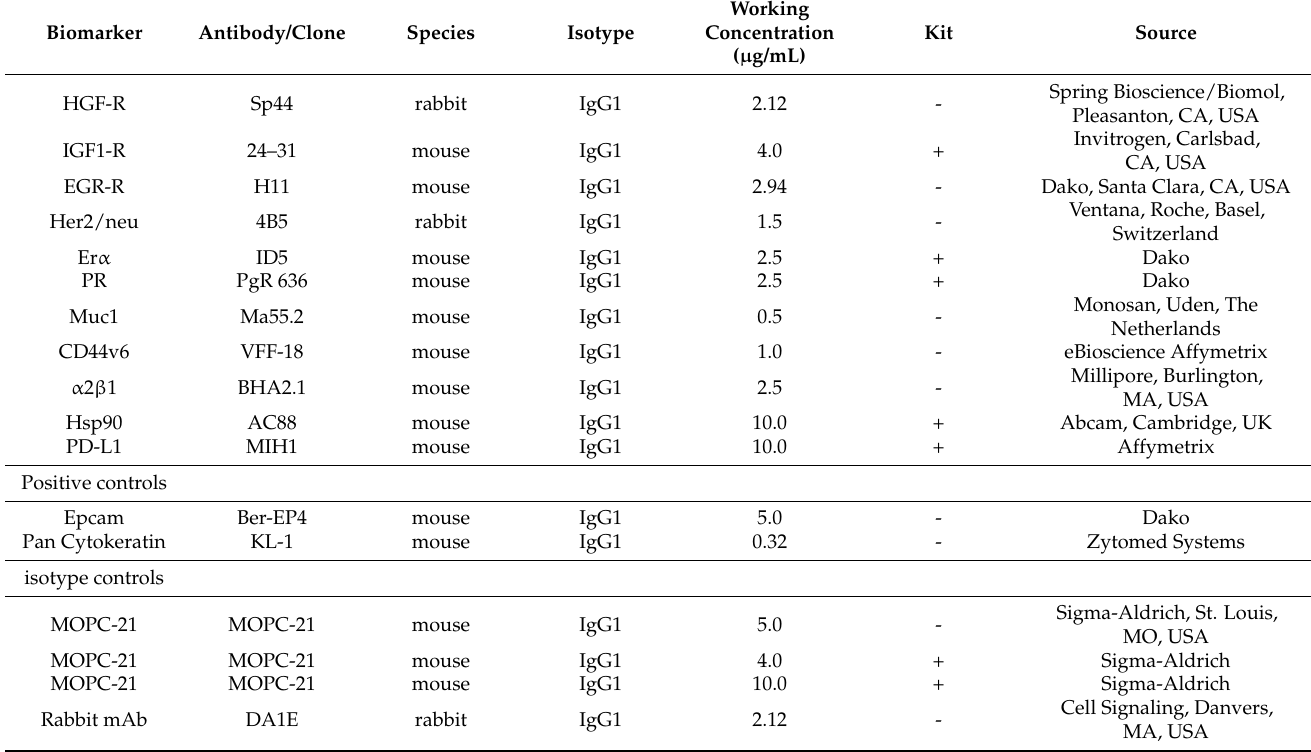
Table 1. Antibody Panel for Immunophenotyping of Colorectal Liver and Lung